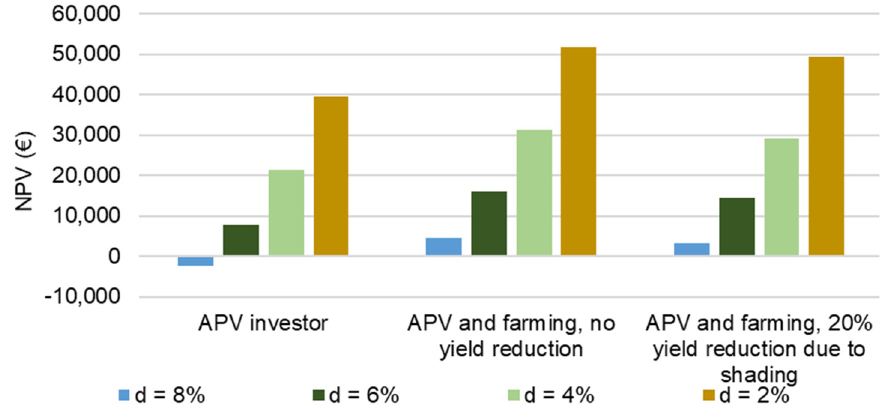
Figure 13. NPVs under different scenarios with varying discount rates.